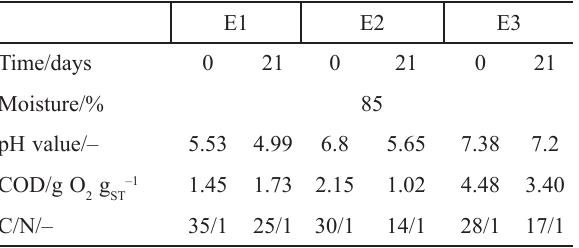
Table 4 – Physicochemical characterisation of experiments E1, E2 and E3 during anaerobic digestion